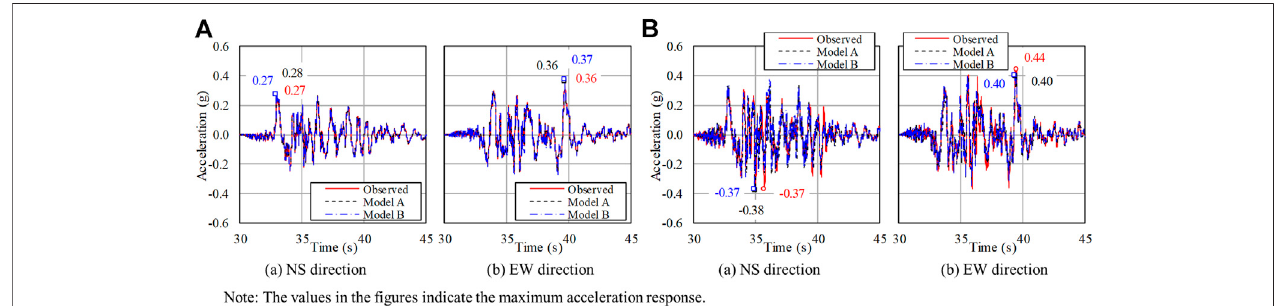
FIGURE 8 | Comparison of acceleration time histories at (A) 7-R2 on B3F and (B) 7-R1 on 3F.